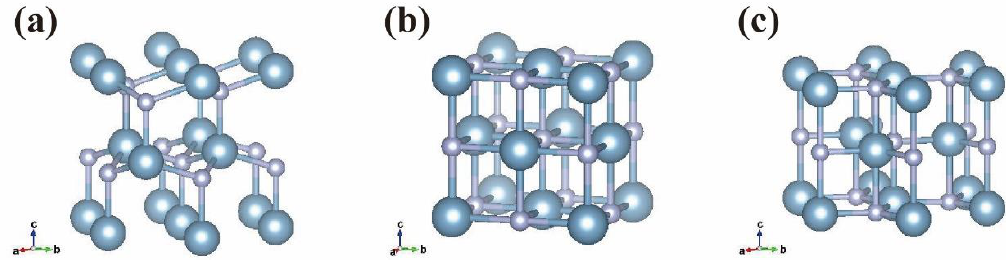
Figure 1. The crystal structures of ( a ) wurtzite, ( b ) rock salt, and ( c ) non-polar hexagonal phases. The blue and gray spheres represent the metal and nitrogen atoms, respectively.